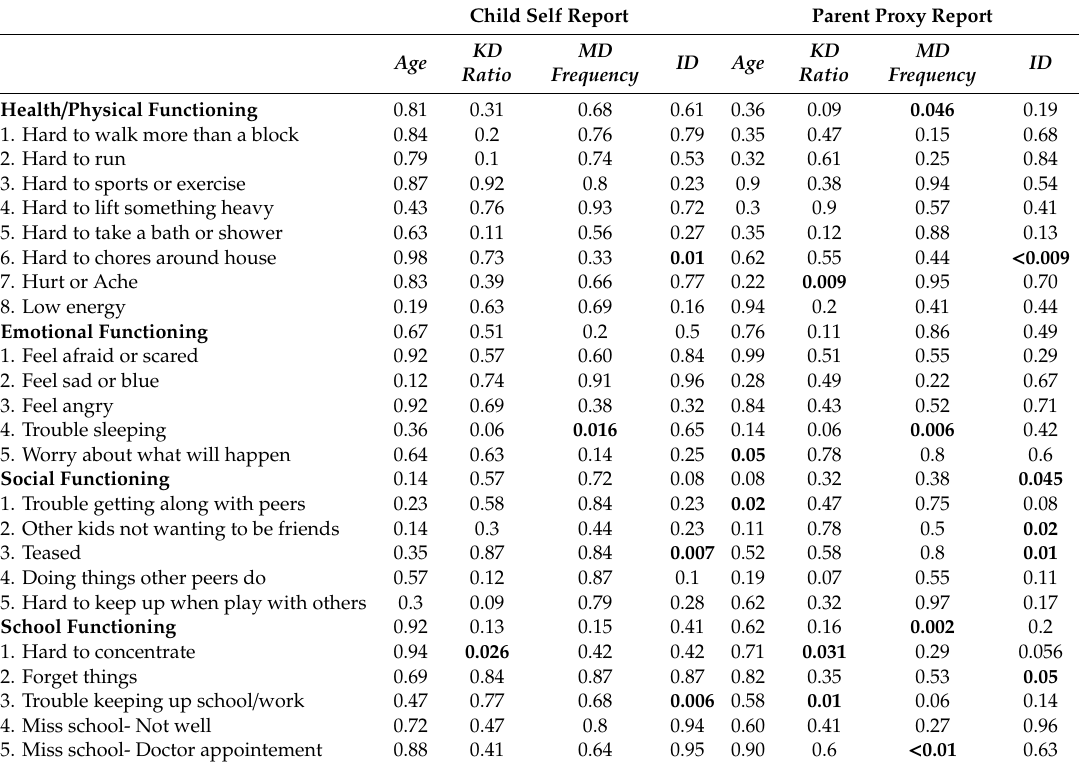
Table 2. p -value results of the correlation